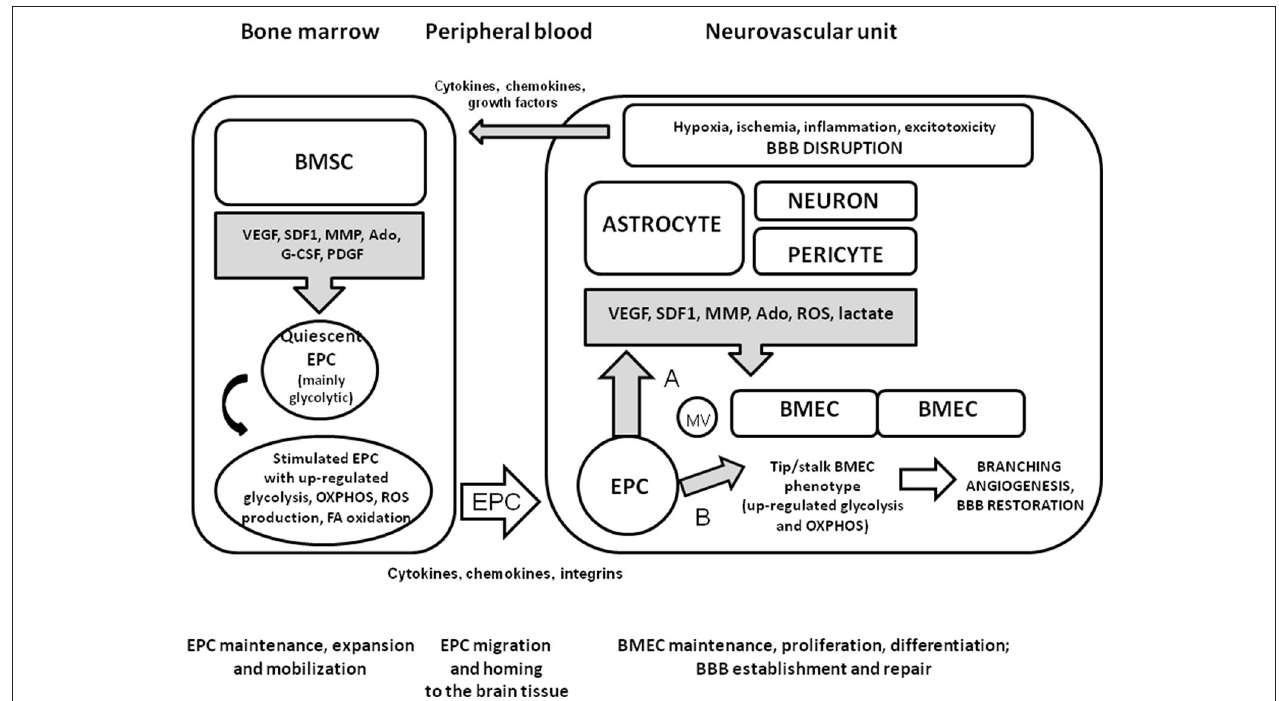
FIGURE 1 | Mobilization and homing of EPC to the injured brain tissue. Within the NVU, pericytes and perivascular astrocytes produce the molecules with pro-angiogenic properties upon neuronal overexcitation, hypoxic or ischemic brain injury, BBB dysfunction, or neuroinflammation. Bone marrow stromal cells secrete various factors contributing to maintenance or expansion of EPC when needed. In a quiescent state, EPC have high glycolytic activity due to relatively hypoxic micronevironment within the clonogenic niche. Being activated by cytokines, chemokines, growth factors whose systemic and local concentrations are elevated due to brain injury, EPC up-regulate metabolic pathways for effective energy production (glycolysis, mitochondrial respiration, fatty acid oxidation). Generation of ROS is enhanced as a side-effect of mitochondria activation, but is counteracted by well-established antioxidant machinery in EPC. Homing of recruited EPC to cerebral microvessels is driven by cytokine-, chemokine-, and integrin-based mechanisms. Upon arrival at the site of BBB disruption, EPC release pro-angiogenic factors and membrane vesicles enriched with EPC-specific proteins and mRNA (A); incorporate into the endothelial layer or donate organelles to the stressed EC (B). These mechanisms lead to the stimulation of branching angiogenesis associated with the activation of tip and stalk EC, and re-establishment of